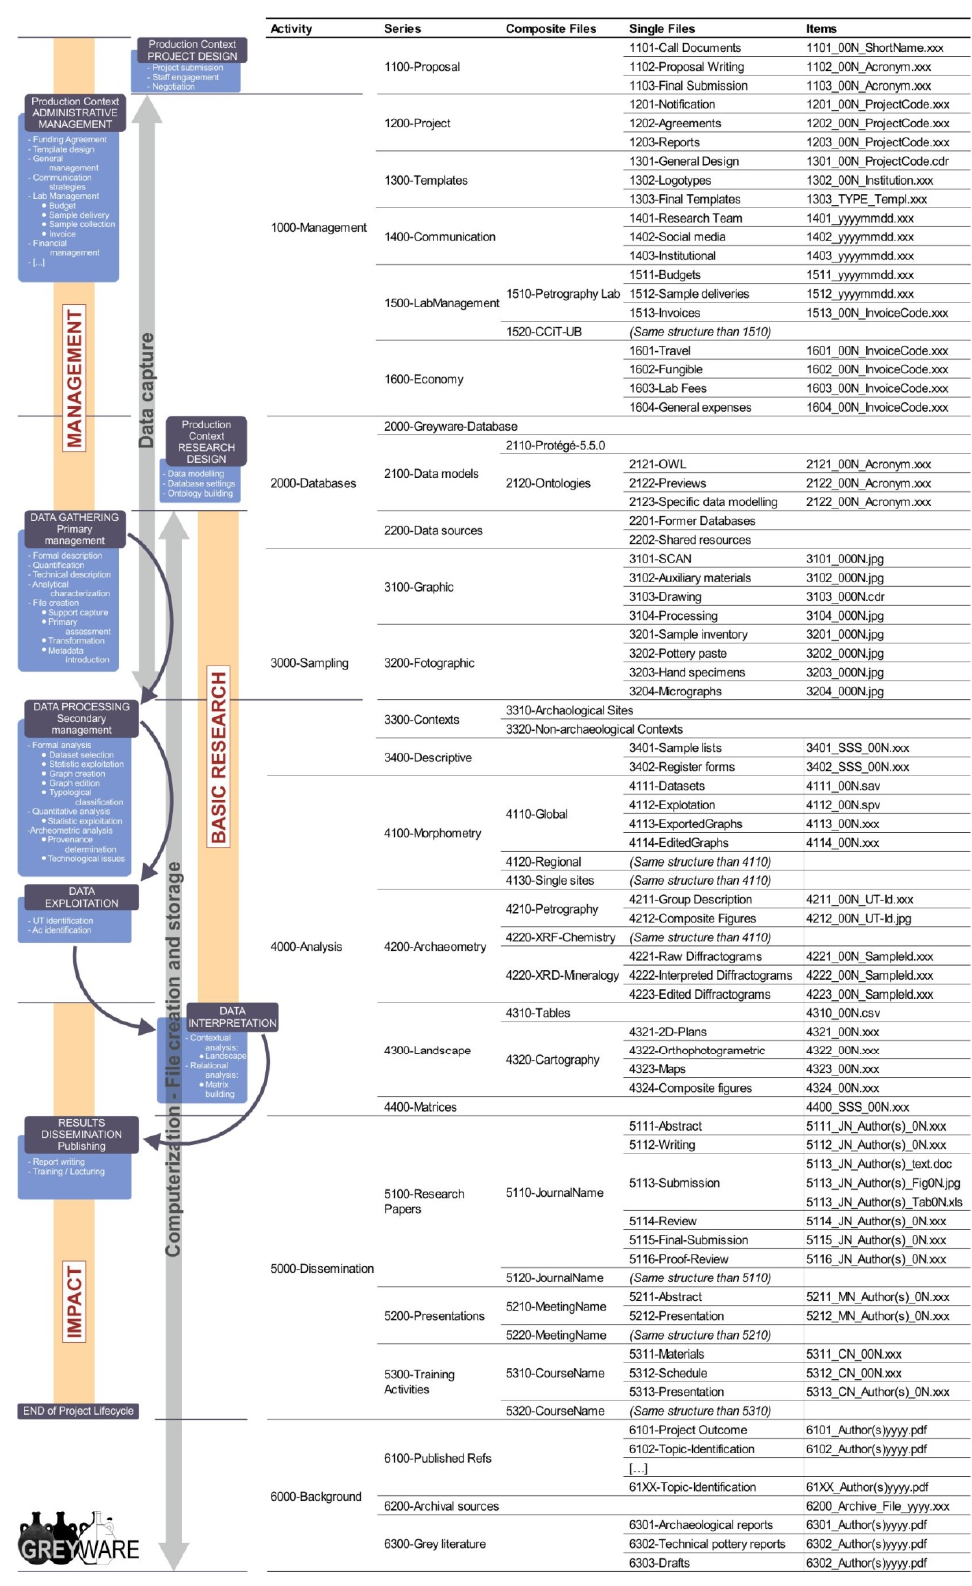
Figure 3. Classification chart of processes, series and files.